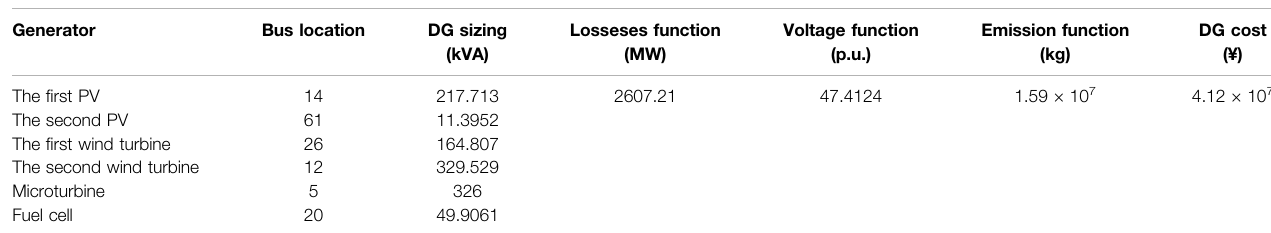
TABLE 2 | Optimization results of MOPSO.